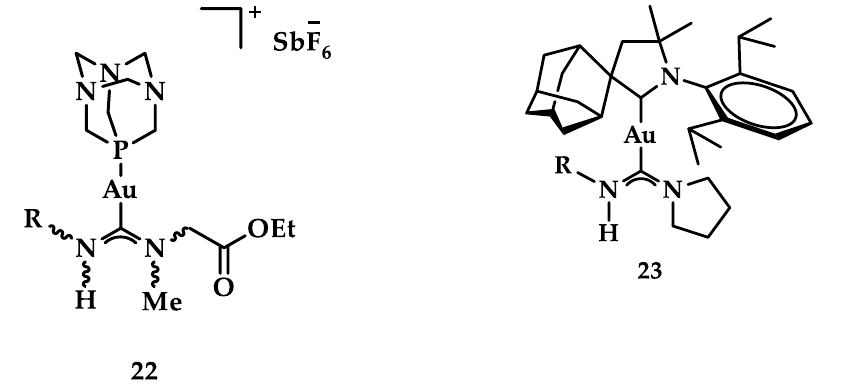
Figure 25. Chemical structure of mixed carbene compounds 22 and 23 .